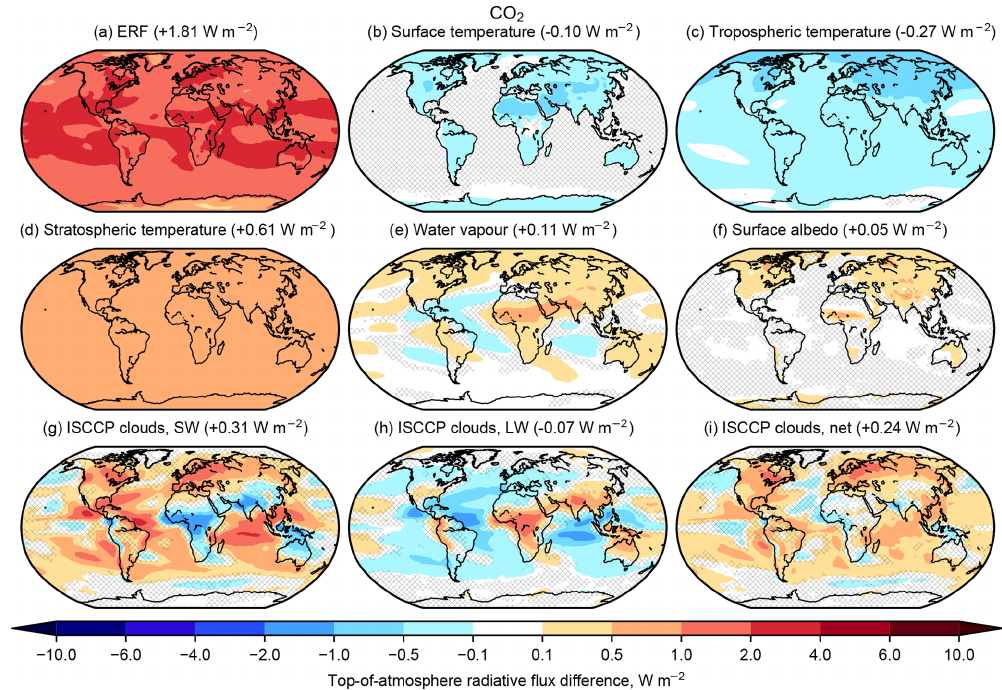
Figure 6. Multi-model mean spatial patterns of (a) effective radiative forcing, (b–f) adjustments and (g–i) cloud contributions to ERF for 1 . 4 × CO 2 . Hatched regions are where less than 75% of models agree on the sign of the change.